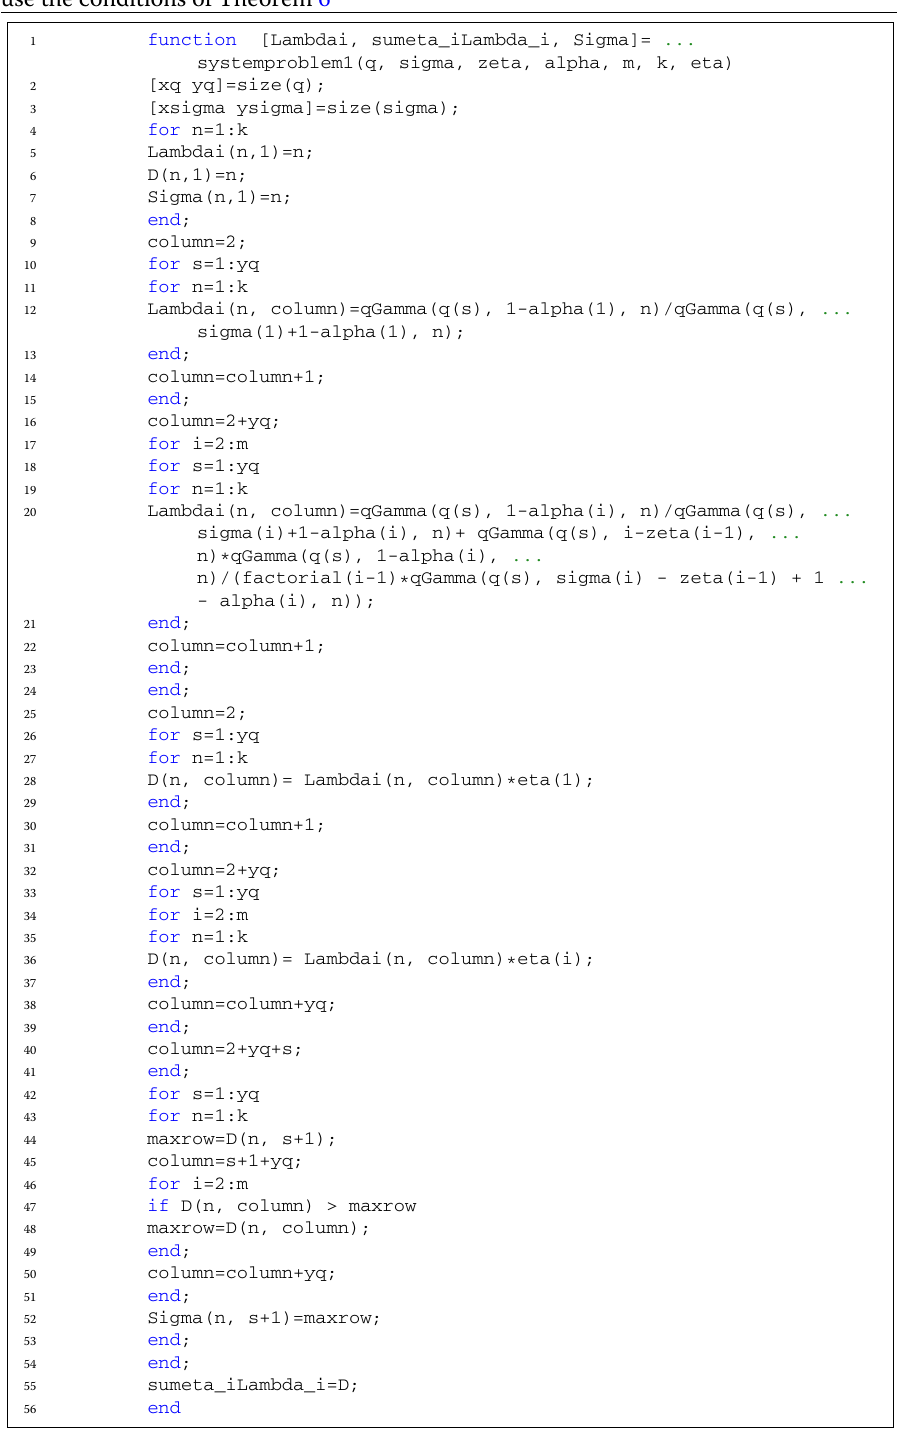
Algorithm 6 The proposed method for solving problem (28) in Example 1 for which we use the conditions of Theorem